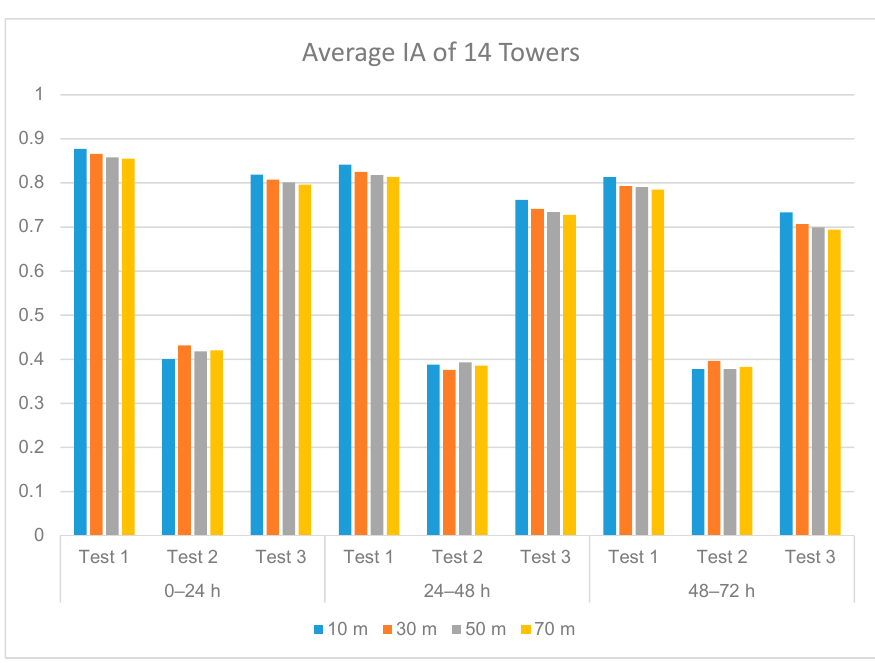
Figure 17. Wind speed IA of sensitivity test results.